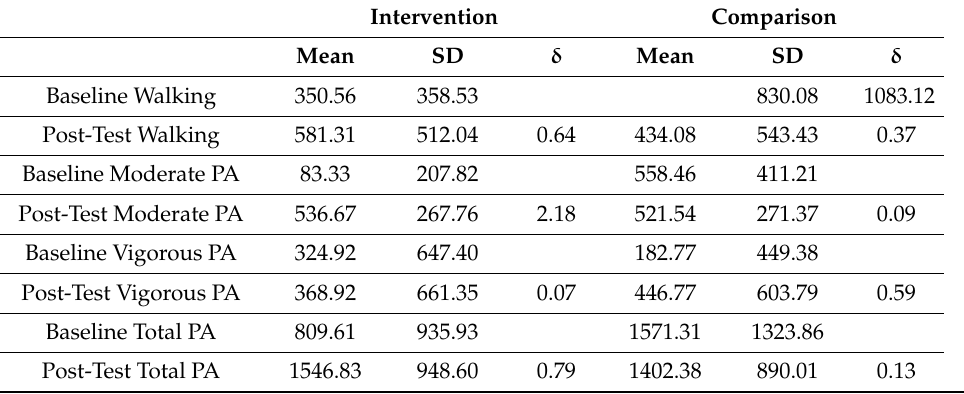
Table 5. Baseline and post-test results of PA variables by group.